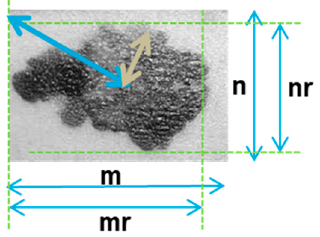
Figure 5. Graphical representation of the nevus image processing done by feature F 12 .